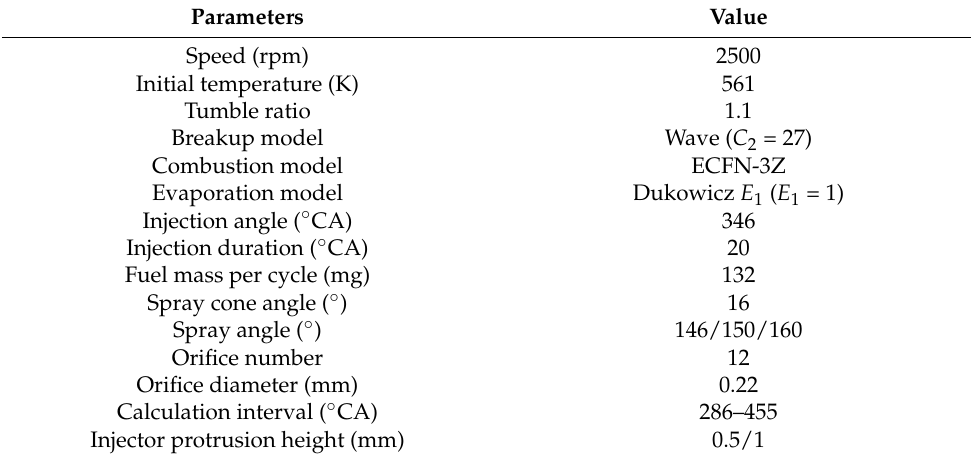
Table 9. Parameters of the combustion system.